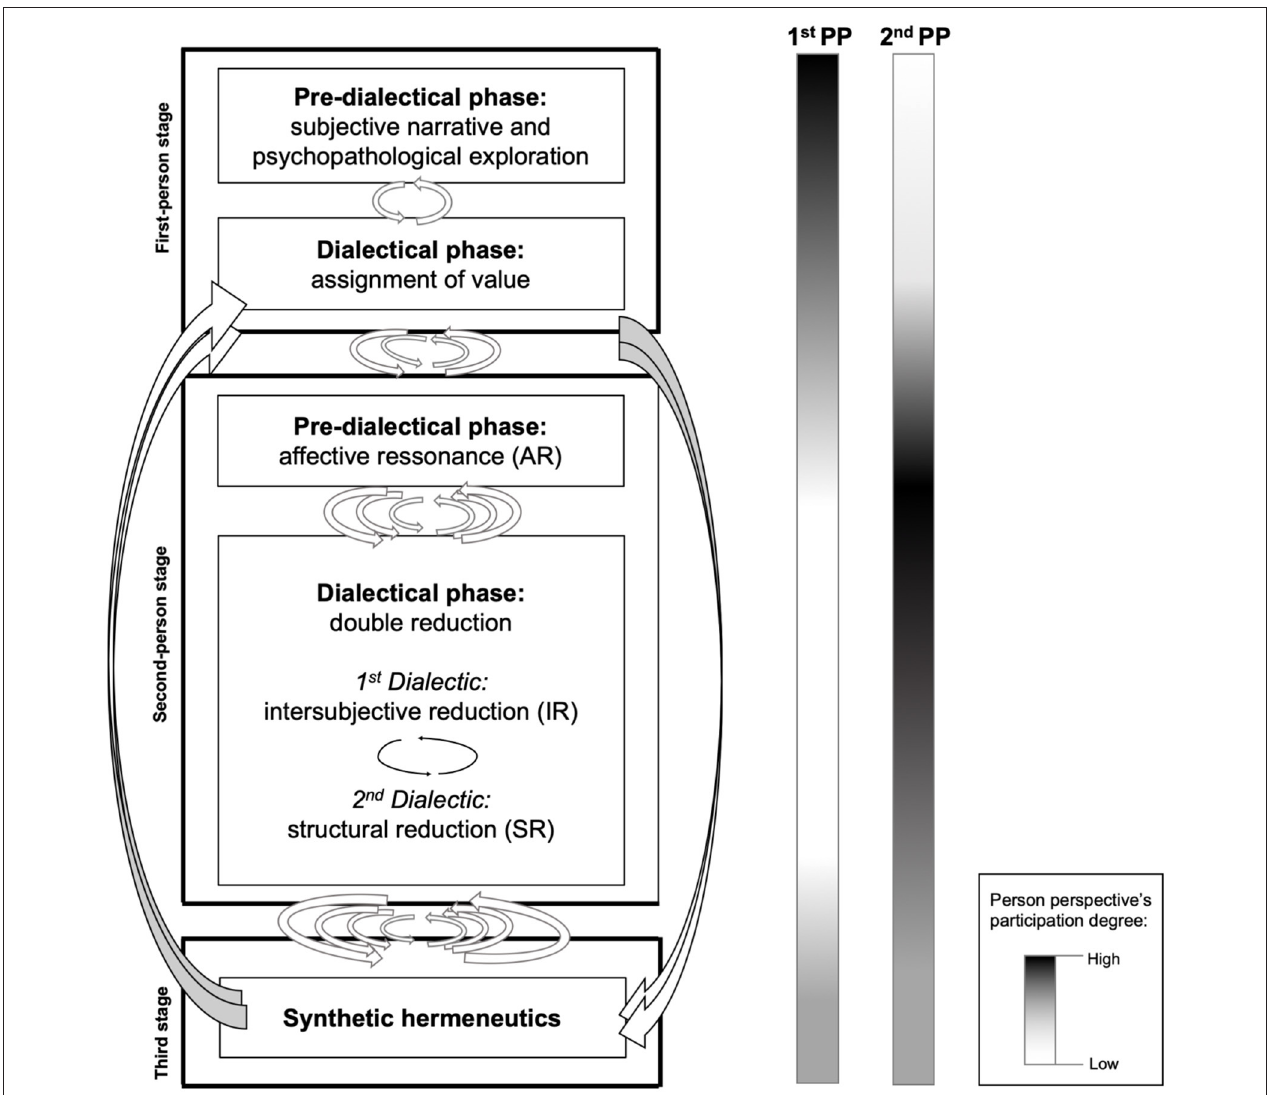
FIGURE 1 | The stages of dialectical phenomenological diagnosis, with increasing degree of complexity, from top to bottom. The columns on the right indicate the degree of participation of each person at each